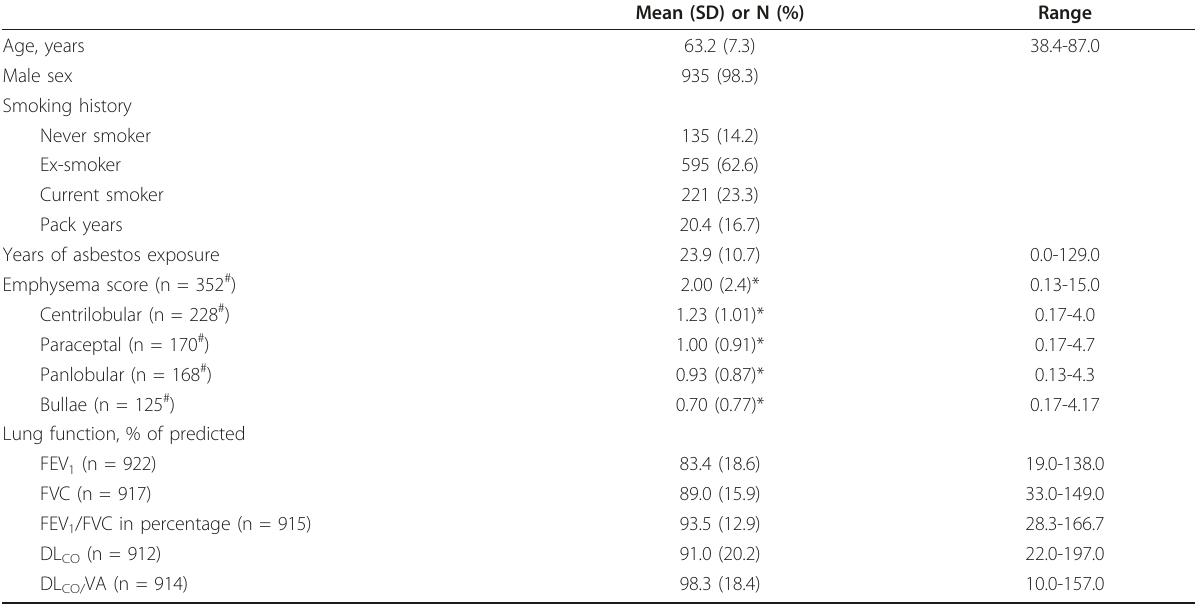
Table 1 Selected characteristics of the study